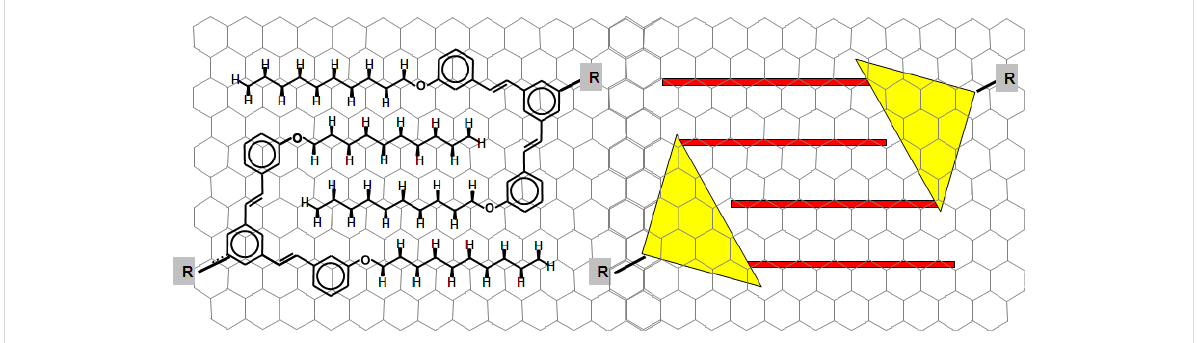
Figure 1: Molecular structure and schematic representation of the “molecular clip” illustrating its specific molecular bonding onto HOPG and showing the rigorous preservation of the Groszek structure [27] for the n- alkyl chains. Figure adapted with permission from [26], copyright 2007 Wiley-VCH Verlag GmbH & Co.